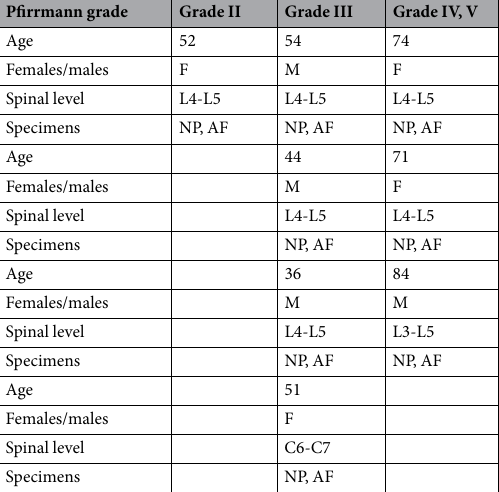
Table 3. Clinical pathology and data for tissue samples used in the microarray